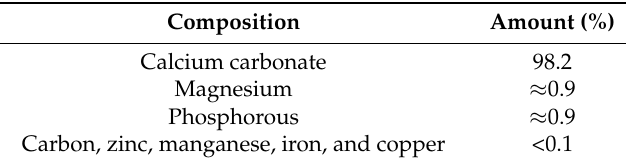
Table 1. Chemical composition of ES particles